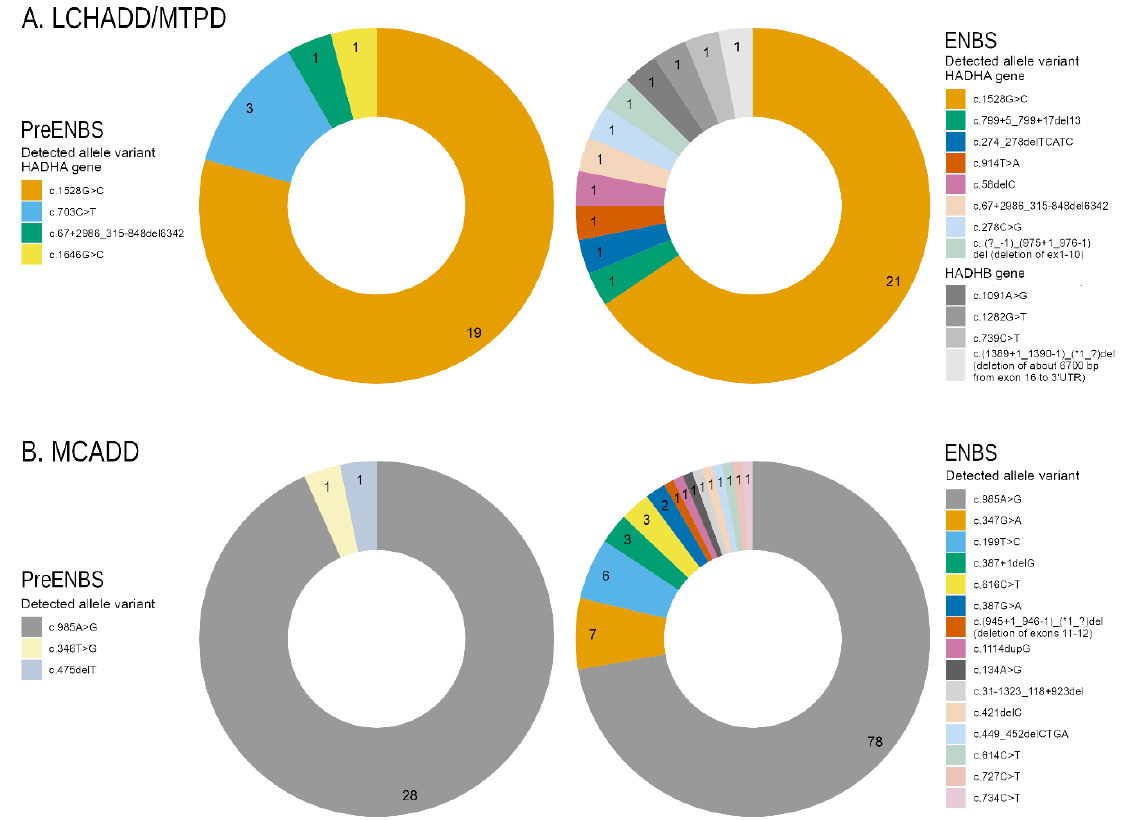
Figure 1. Distribution of genetic variants: ( A ) Graphs show proportion of alleles in HADHA and HADHB genes in patients diagnosed with LCHADD/MTPD before ( n = 12) and after ENBS ( n = 16). ( B ) Graphs show proportion of ACADM alleles in MCADD patients before ( n = 15) and after ENBS ( n = 54). Details on genotypes are shown in Supplementary Table S1.